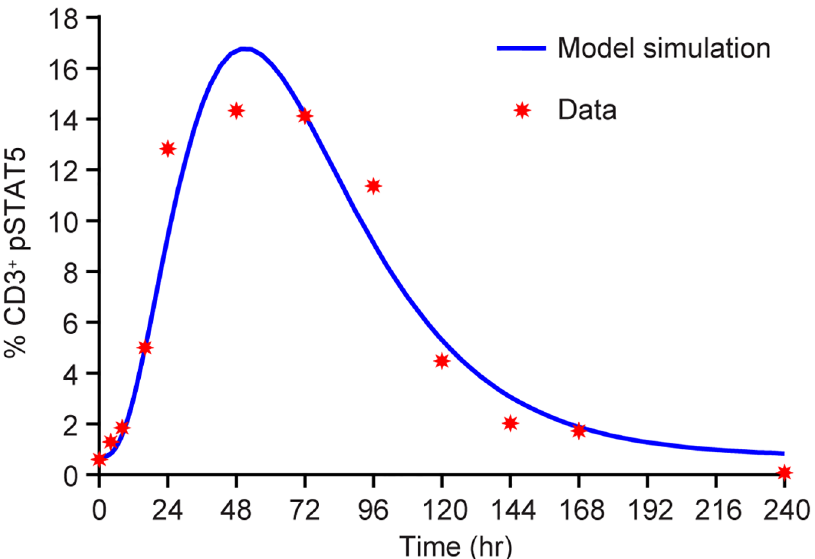
Fig 11. The model correctly estimatesexperimental % pSTAT5 activation from the receptor occupancy determination. Model fit (blue line) of pSTAT5 signalingfrom NKTR-214 as compared to the observedmeasuredvalues (symbols).